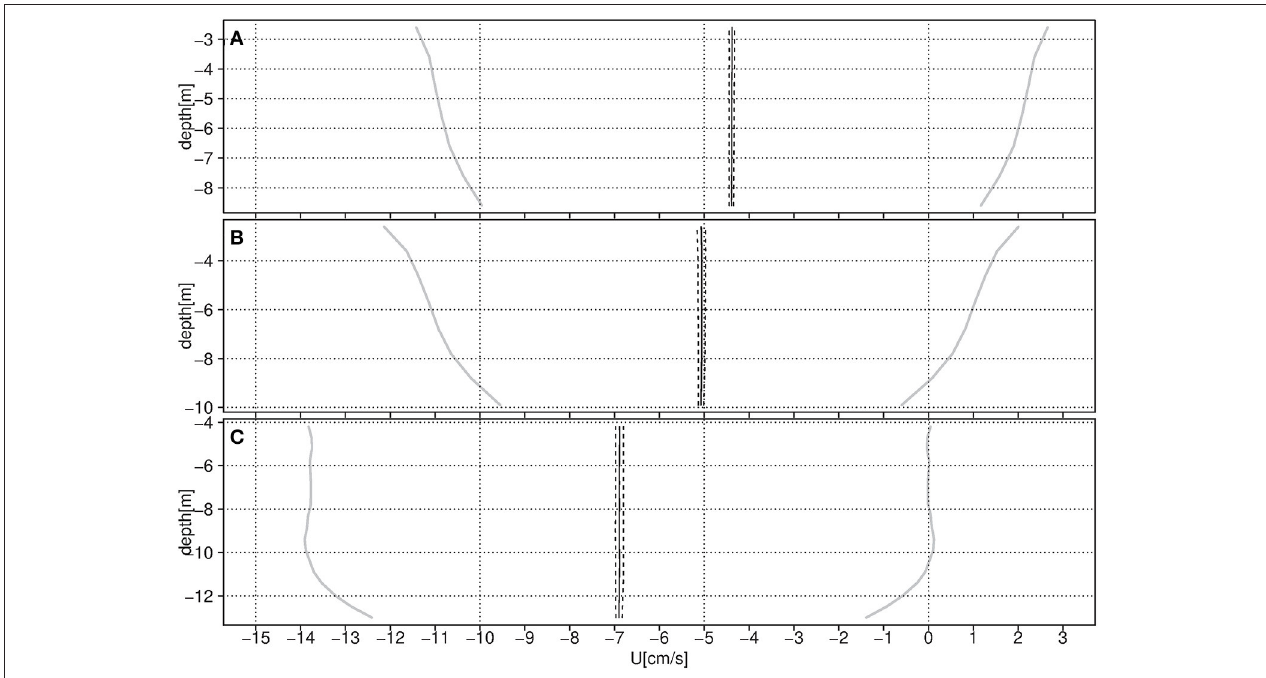
FIGURE 3 | Mean zonal current profile ( U in cm/s) for (A) Lerma, (B) Champoton, and (C) Chenkan. Solid line—mean profile, dash line- − 95% CI, and gray solid line—one SD.